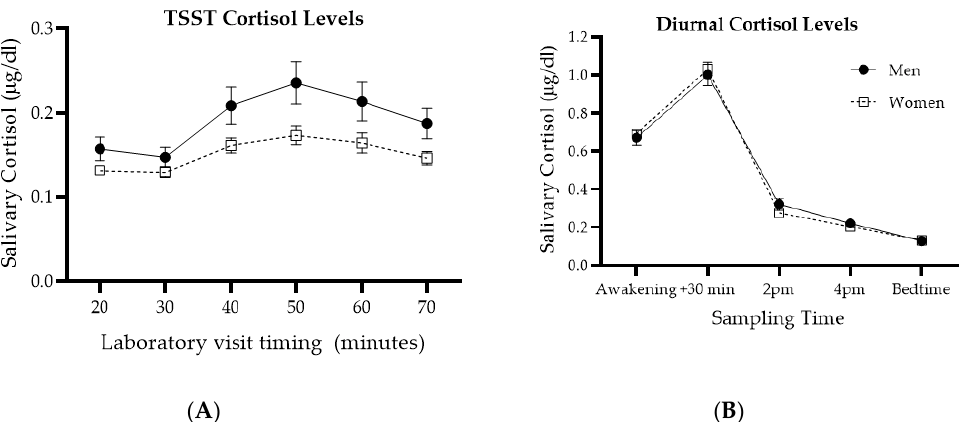
Figure 1. Diurnal and Trier Social Stress Task (TSST) cortisol levels for men and women. Panel ( A ) shows samples taken during the laboratory visit, each 10 min, with the TSST procedure occurring between 30 and 40 min. Panel ( B ) shows diurnal cortisol levels averaged over two typical working days. Adapted